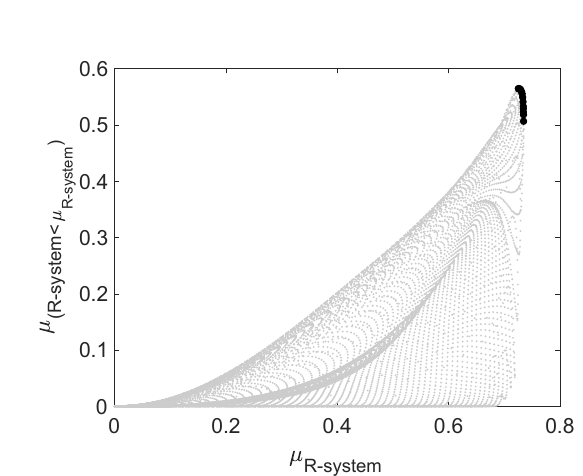
Figure 4. Resilience–robustness trade-off. Each point represents, µ R and µ R<µ of the coupled system with a given policy. The system black dots represent a set of Pareto-optimal